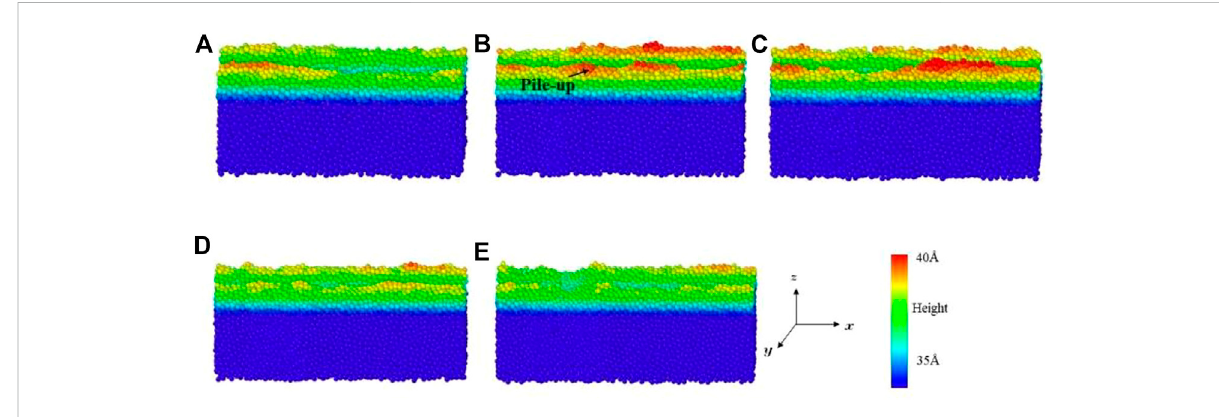
FIGURE 2 Scratched surfaces in the fi ve different Al 2 O 3 content models at 400 ps: (A) pure Fe-based amorphous model; (B) 5 wt% Al 2 O 3 /Fe amorphous composite model; (C) 10 wt% Al 2 O 3 /Fe amorphous composite model; (D) 15 wt% Al 2 O 3 /Fe amorphous composite model; (E) 20 wt% Al 2 O 3 /Fe amorphous composite